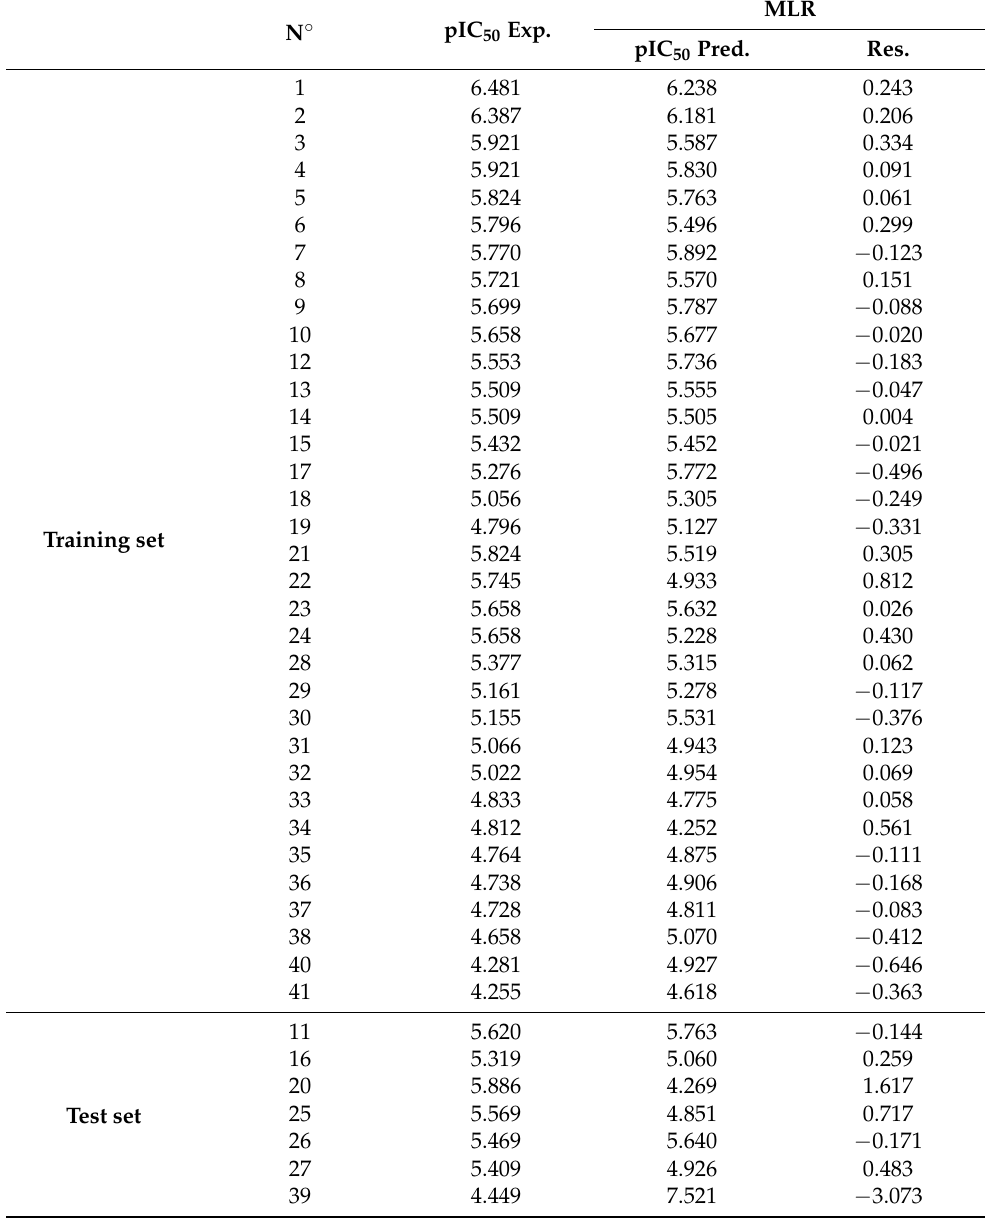
Table 2. Experimental and predicted activities (pIC 50 ) and residual values, according to MLR